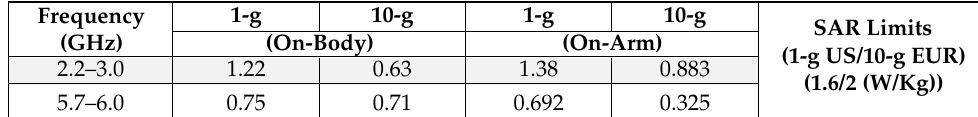
Table 4. Comparison of different SAR values.